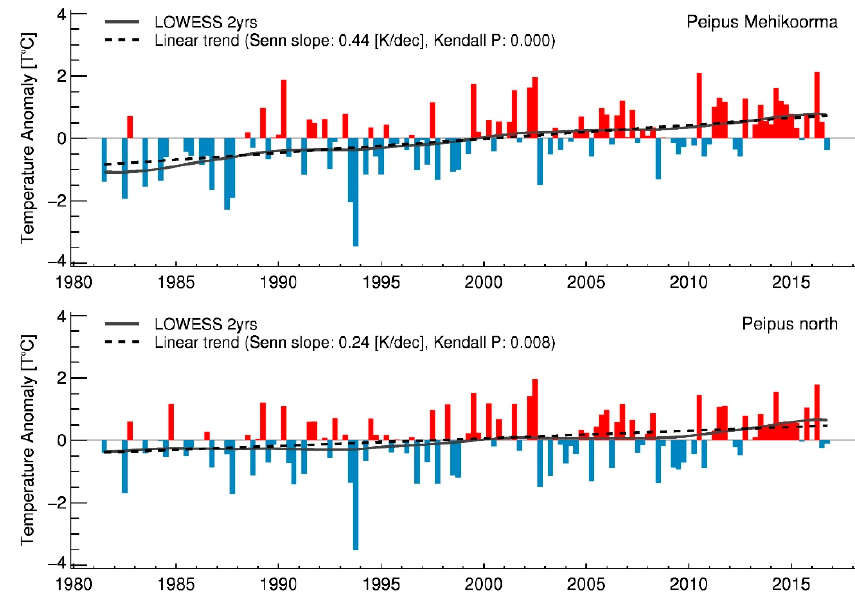
Figure 15. Significant difference in trends within Lake Peipus when comparing the trend near the Mehikoorma in-situ station (see coordinates in Table 2) with the trend in the open waters of the northern part (see coordinates in Table 1).